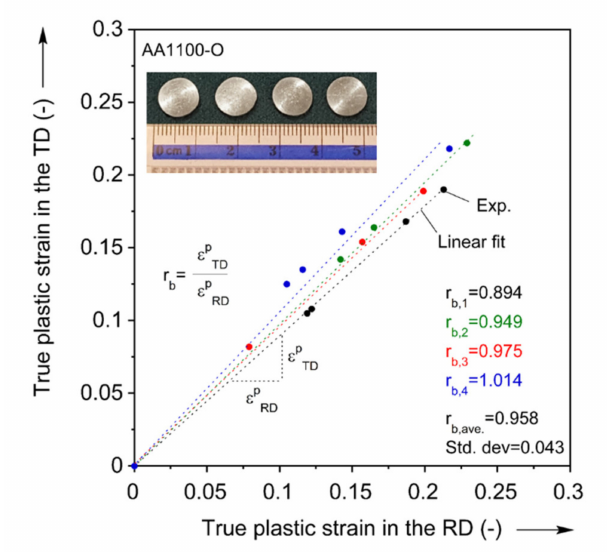
Figure 7. Experiment for disk compression and determination of r b